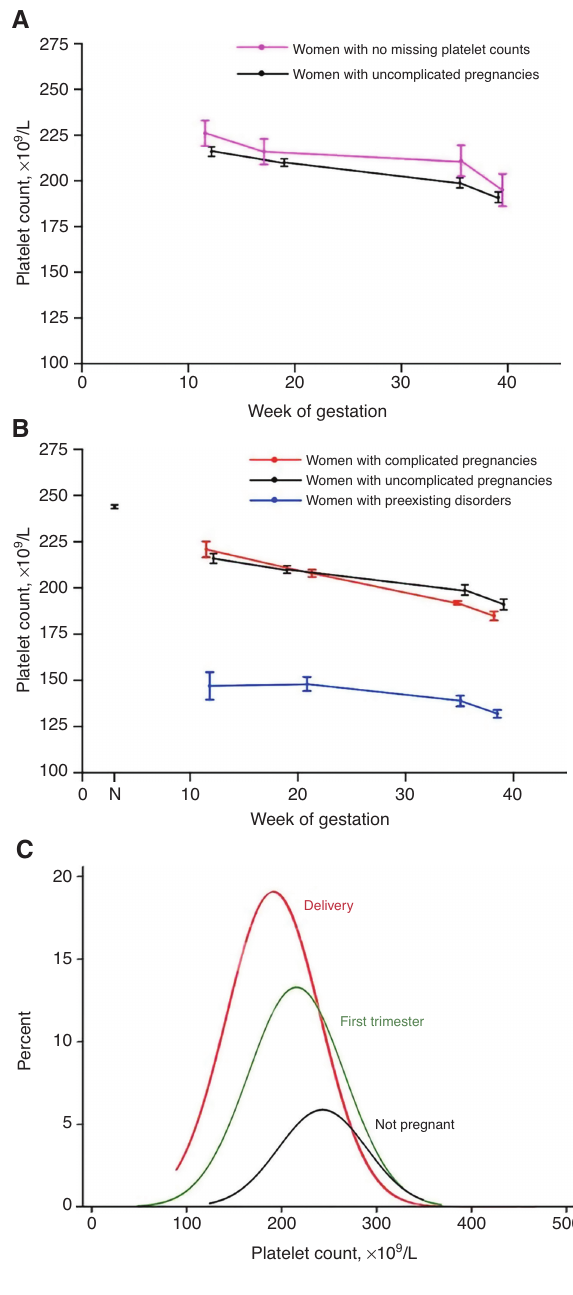
Figure 1: Mean platelet counts over time and platelet count